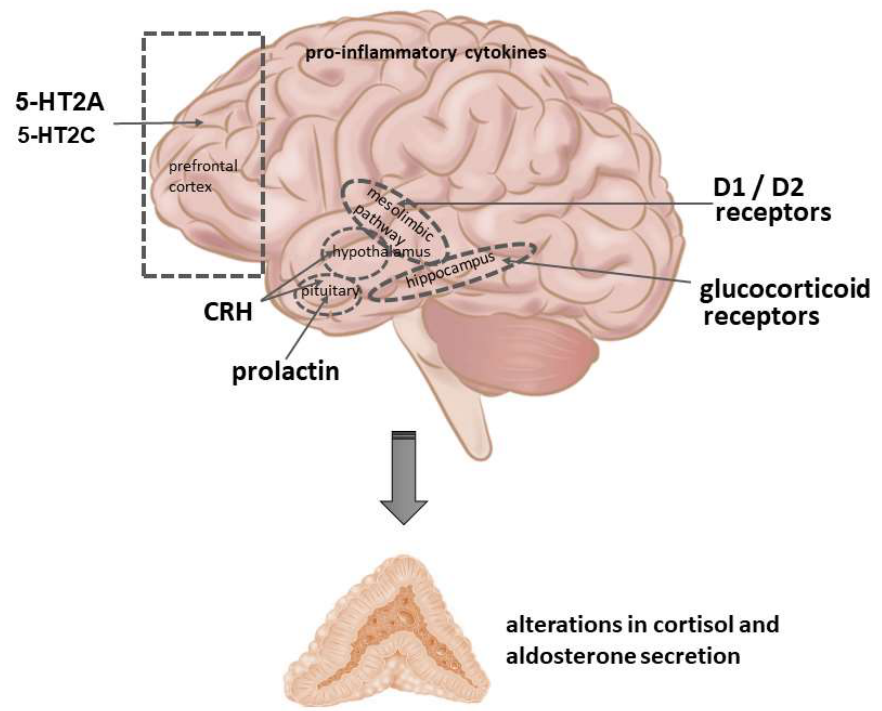
Figure 2. Mechanisms by which antipsychotic drugs may affect cortisol (corticosterone in rodents) and aldosterone secretion. CRH—corticotropin-releasing hormone; D1, D2—dopamine receptor subtypes, 5-HT2A, 5-HT2C—serotonin receptor subtypes.